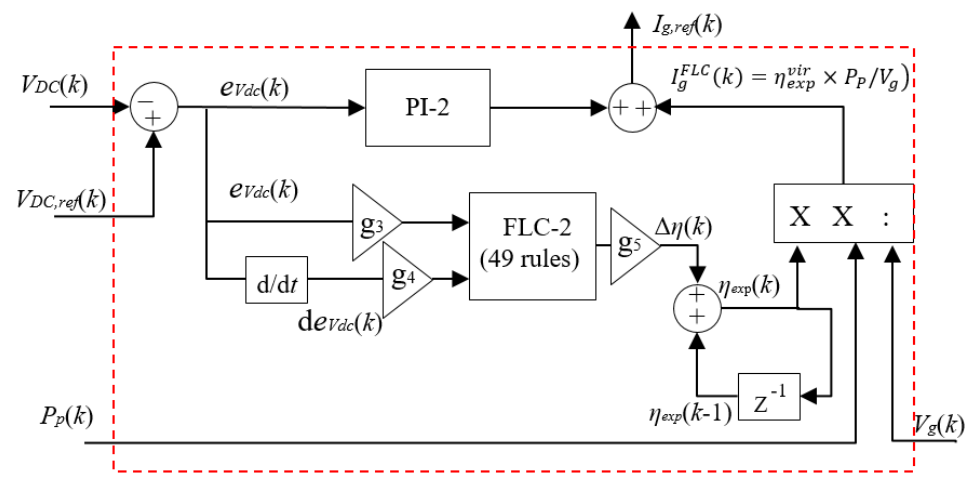
Figure 9. Proposed PI-fuzzy hybrid control scheme, where g 3 , g 4 and g 5 are design coefficients